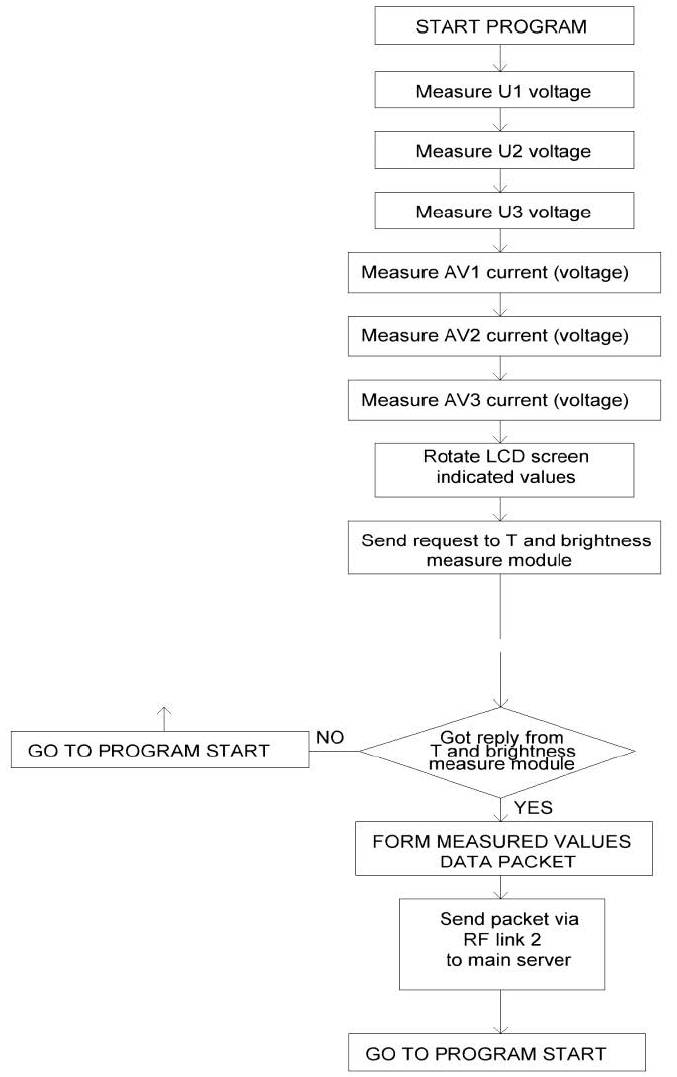
Figure 5. Algorithm of operation of microcontroller program for operating parameter monitoring and data processing system.